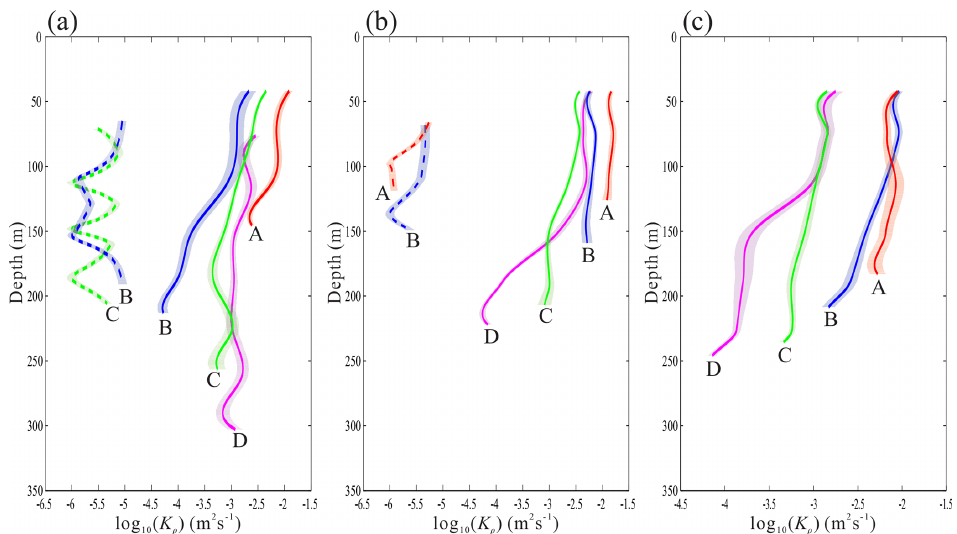
Figure 10. The vertical distribution of diffusivity from seismic data compared with the mixing scheme. The solid line represents the vertical distribution of diffusivity at the four positions A (red), B (blue), C (green) and D (magenta), and the dotted line represents the parameterized diffusivity at the corresponding positions. The shadow indicates the margins of